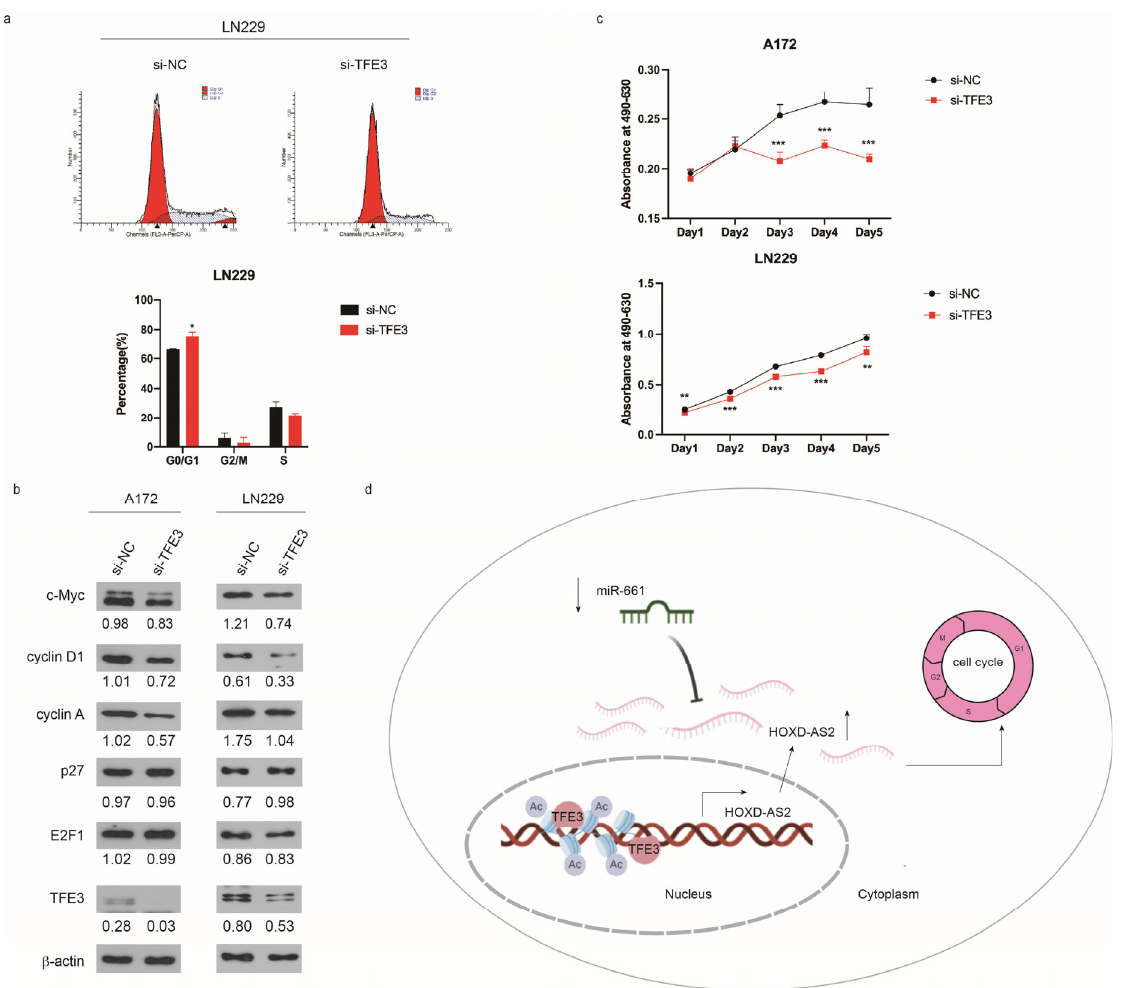
Figure 5. TFE3 regulated cell cycle progression in gliomas. ( a ) Cell cycle was measured by PI staining followed by flow cytometry in LN229. Two ‐ tailed Student’s t ‐ test was used and * p < 0.05. ( b ) Western blot detected cell cycle ‐ associated proteins when knocked down from TFE3 in A172 and LN229 cells. ( c ) Growth curve of A172 cells transfecting TFE3 siRNAs by MTS assay. Data are presented as the mean ± SEM. Two ‐ tailed Student’s t ‐ test was used at each time point. ( d ) Schematic of the proposed mechanism of TFE3 and miR ‐ 661 mediated HOXD ‐ AS2 in glioma cells. Significant results were presented as * p < 0.05, ** p < 0.01, *** p < 0.001.